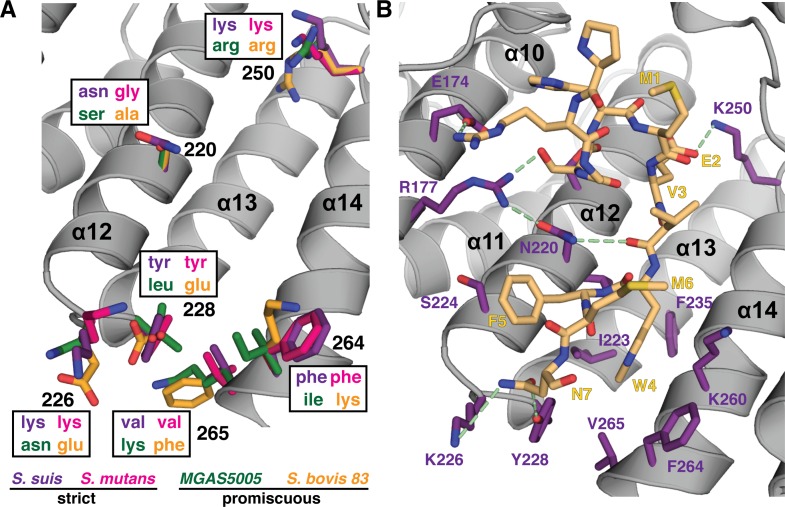
Structural comparison of the XIP binding pocket between different peptide recognition types.(A) Residues from strict and promiscuous ComR proteins are compared and labeled by color. S. suis in purple, S. mutans in pink, MGAS5005 in green, and S. bovis 83 in orange. (B) Crystal packing artifact of the N-terminus (yellow) may mimic initial ComR peptide recognition. Residues making van der Waals contacts and/or hydrogen bond with the peptide are shown in purple, hydrogen bonds are represented by a dashed green line.